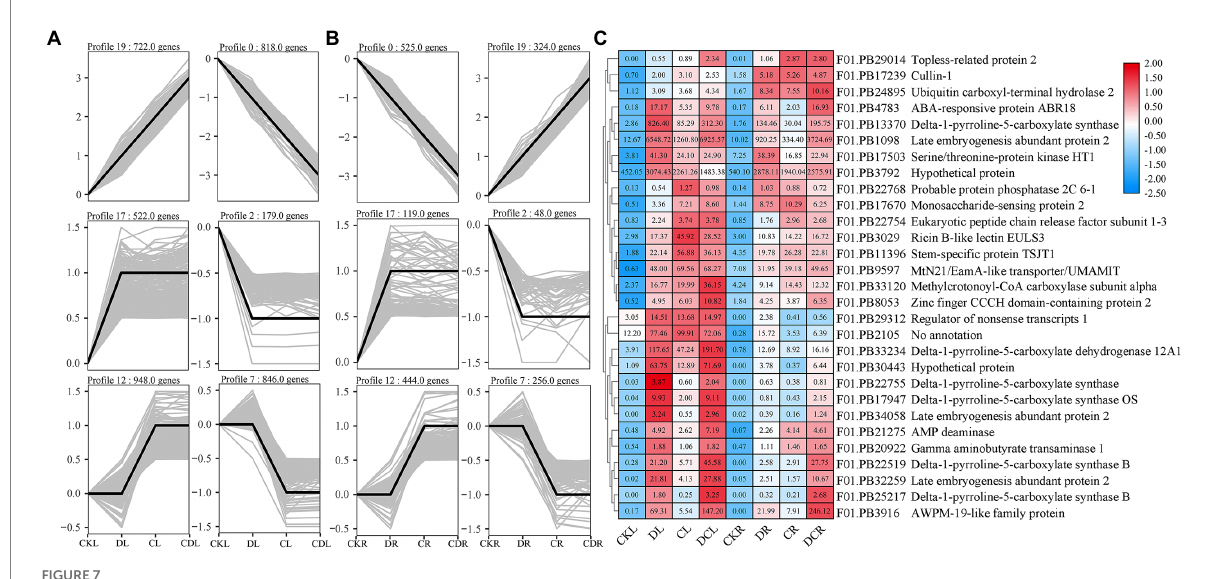
FIGURE 7 Dynamic progression of the common vetch transcriptome under cold-drought stress. (A,B) show the dynamic expression of DEGs in leaves and roots, respectively, by K-means clustering. (C) shows the expression profile of shared DEGs in profile 17 between leaves and roots. CKL and CKR are leaf and root control groups, respectively, DL, CL, and DCL are leaf under single drought, single cold, and cold-drought combined stress respectively, DR, CR, and DCR are root under single drought, single cold, and cold-drought combined stress, respectively.